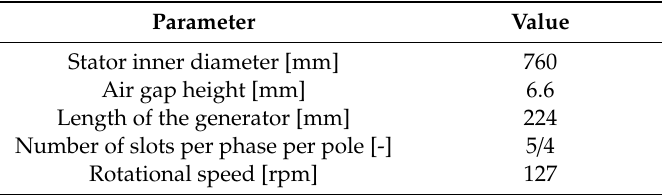
Table 3. Stator parameters of the permanent-magnet synchronous generator